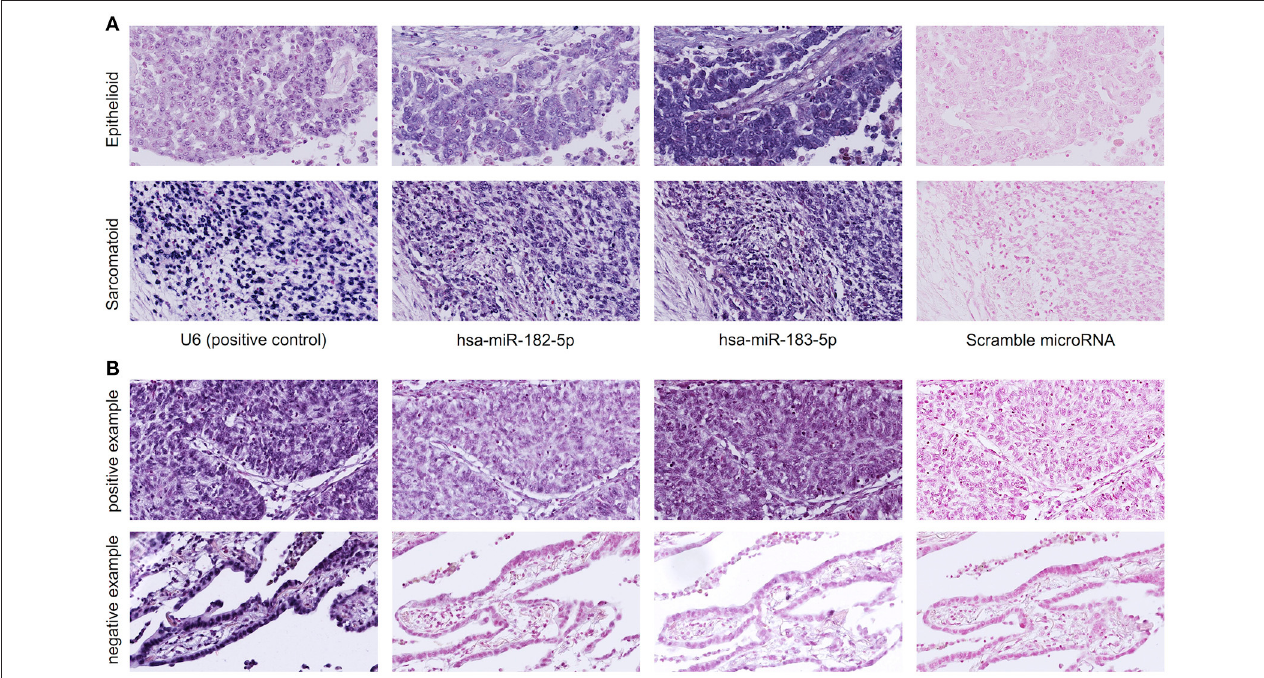
FIGURE 1 | (A) MicroRNA in situ hybridization of human mesothelioma tissues shows miR-182 and miR-183 expression in the cytoplasm and nuclei of mesothelioma cells. U6 probe is the positive control, and scramble probe is the negative control. Upper panel shows representative images of epithelioid mesothelioma. Lower panel shows representative images of sarcomatoid mesothelioma. (B) The specificity of miR-182 and miR-183 probes is confirmed by in situ hybridization of lung cancer tissues showing both expression of miR-182 and miR-183 in lung squamous cell carcinoma (upper panel and no expression in lung adenocarcinoma (lower panel).